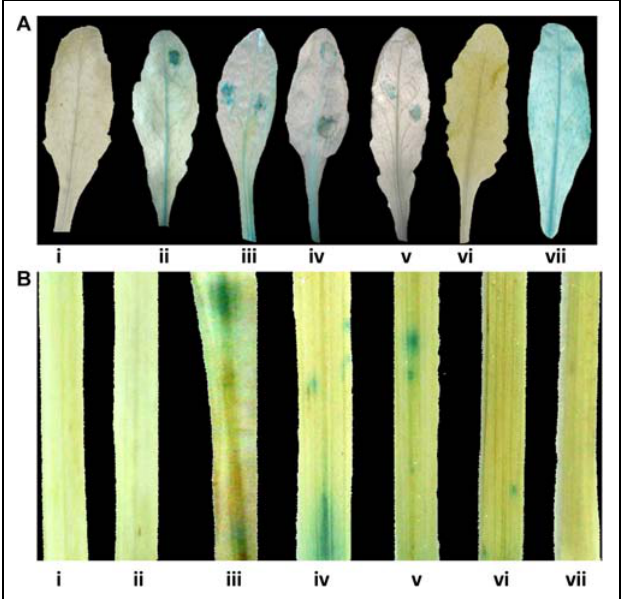
FIGURE 4 | Glucuronidase (GUS) histochemical assays for functional validation of different CYP76M7 promoter deletion. (A) Arabidopsis mock inoculated (i) Pcyp2004; and M. oryzae challenged (ii) Pcyp2004; (iii) Pcyp1456; (iv) Pcyp1167; (v) Pcyp520; (vi) Pcyp222; (vii) constitutive 35 S promoter (positive control) plants. (B) Transient expression in rice leaves bombarded with (i) pBI 101 empty vector; (ii) mock inoculated Pcyp2004; and M. oryzae challenged (iii) Pcyp2004; (iv) Pcyp1456; (v) Pcyp1167; (vi) Pcyp520: (vii) Pcyp222. FIGURE 5 | Glucuronidase histochemical assay to know wound